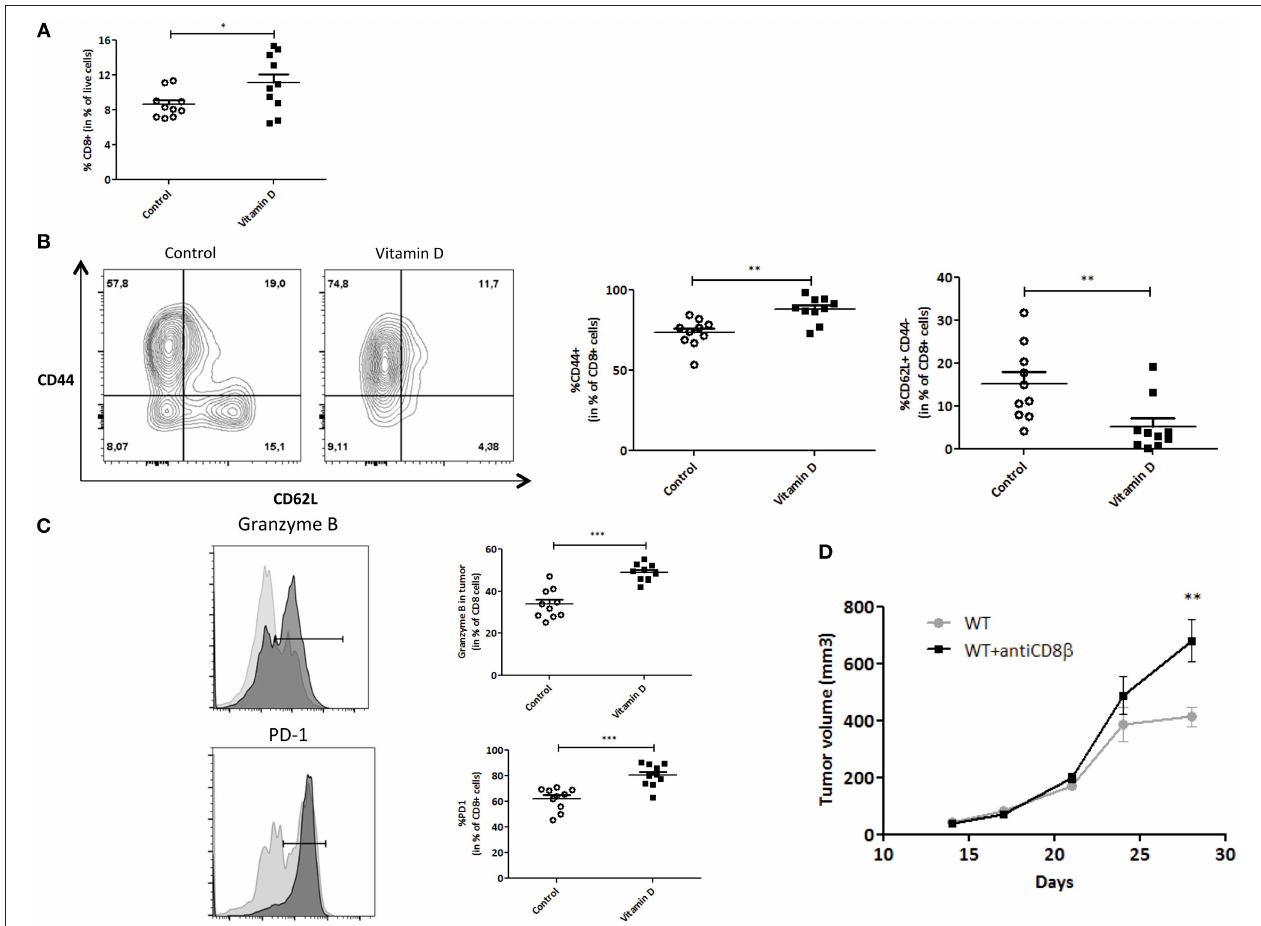
FIGURE 2 | Vitamin D modulates the CD8 + T cell phenotype in the tumor in basal conditions. Flow cytometry analysis of the tumor from Control and Vitamin D-treated mice. (A) Quantification of the CD8 + T cells. (B) Quantification of the CD8 + T cell markers (CD44, CD62L) (C) and Granzyme B and PD-1. (D) CD8 + T cells were depleted by the injection of CD8 β mAb in C57BL/6J (WT) mice. Then, EO771 cells were injected in the fat pad of the mammary glands ( n = 12). Tumor size is measured with a caliper. The values of tumor volume (mm 3 ) are reported (Mean ± SEM). Statistical significance between control and VD groups was determined by two-tailed Student’s t -test. * P < 0.05, ** P < 0.01 and *** P <